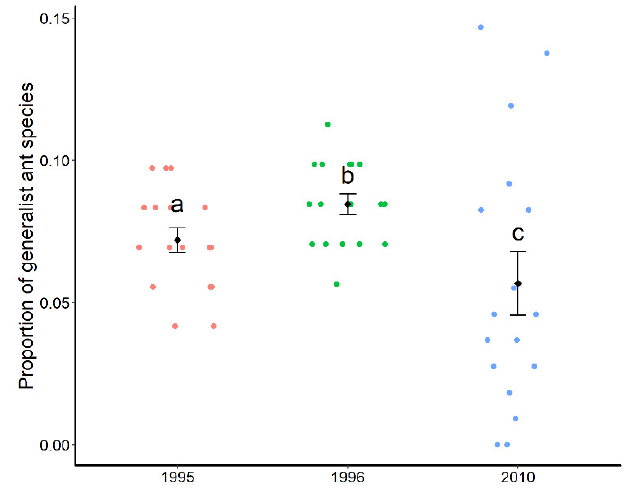
Fig 2. Average similarity of ant species composition across studied fragments, located in southeastern Brazilian Atlantic rain forest. Each point represents a pairwise comparison between fragments using the Jaccard similarity index. To compare averages, we used a mixed model considering each forest fragment identity as a random effect (see main text). The black lozenges represent the average, and the bars represent the standard error. Different letters represent significant differences at alfa = 0.05.